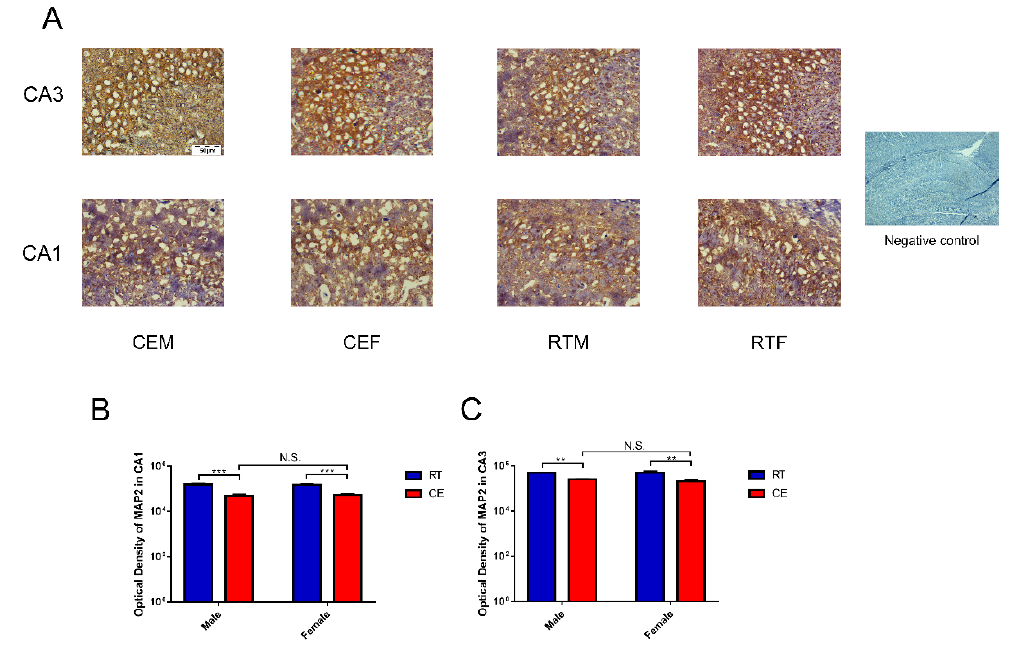
Figure 3. The expression of the neuronal dendrite marker, MAP2, in CA1 and CA3 hippocampus regions as assessed by immunohistochemistry. Immunohistochemical staining of hippocampus tissue ( A ) CA1 and CA3 regions showing MAP2 expression in each group. Scale bar = 50 μ m. The graphs indicate the optical density of MAP2 in the CA1 region ( B ) and the CA3 region ( C ) of the hippocampus. Data were between room temperature male vs. cold exposure male (CEM), room temperature female vs. cold exposure female (CEF), and CEM vs. CEF and were analyzed by two-way analysis of variance. The results are expressed as the mean ± SD (n = 6) from four independent experiments. NS: not significant; ** p < 0.01; *** p < 0.001.